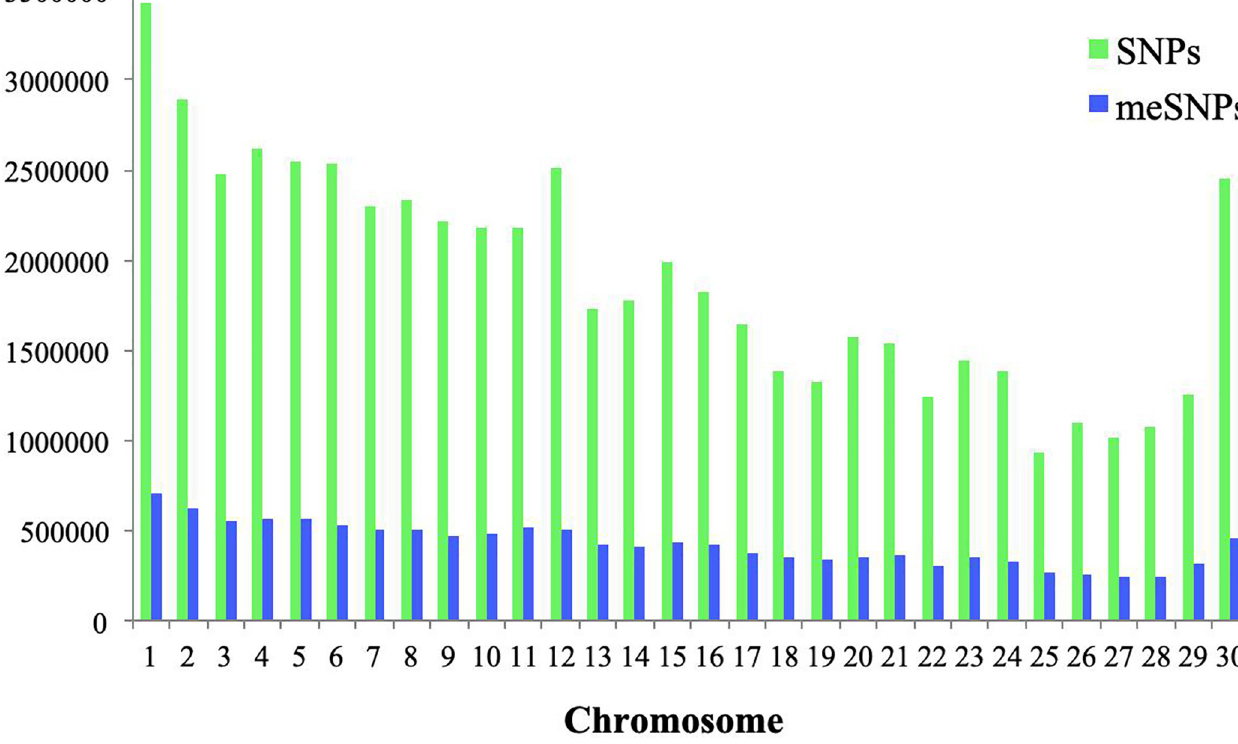
PLOS ONE | https://doi.org/10.1371/journal.pone.0222329 September 12,